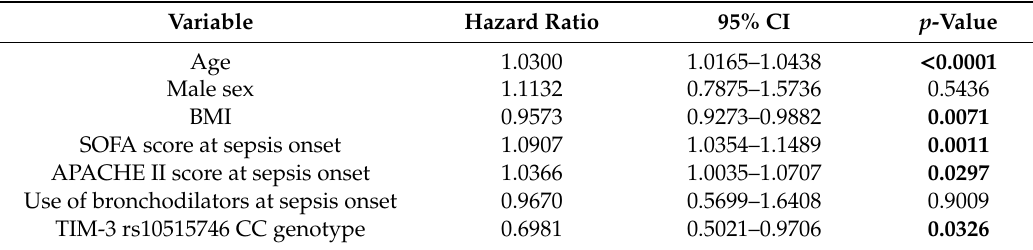
Table6. MultivariateCoxregressionanalysis(28-daymortality)withregardtoTIM-3rs10515746genotypes.